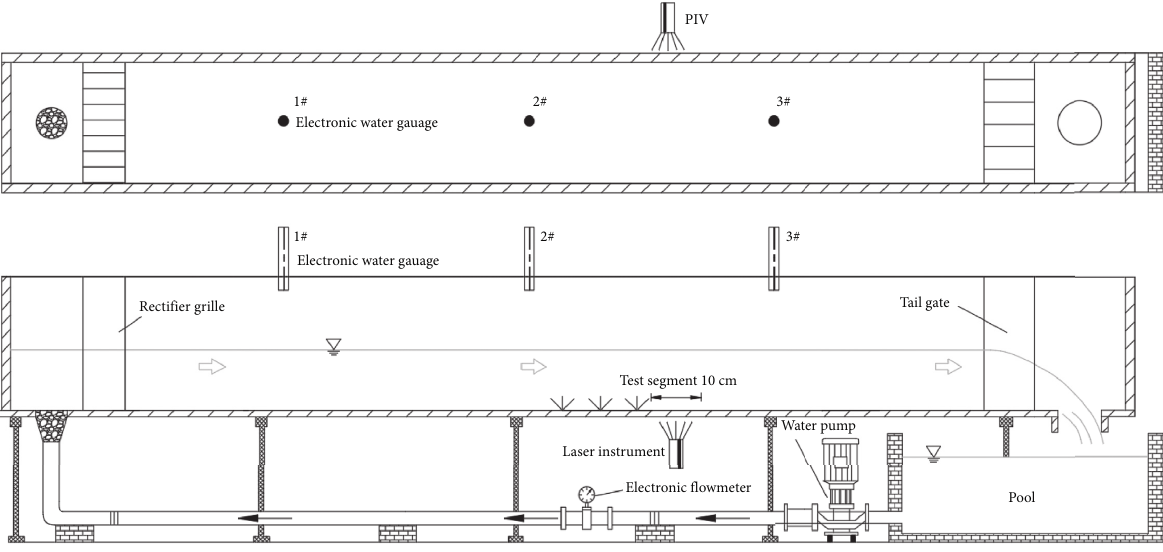
Figure 1: Schematic diagram of the flume test. Table 1: Test conditions and related parameters.